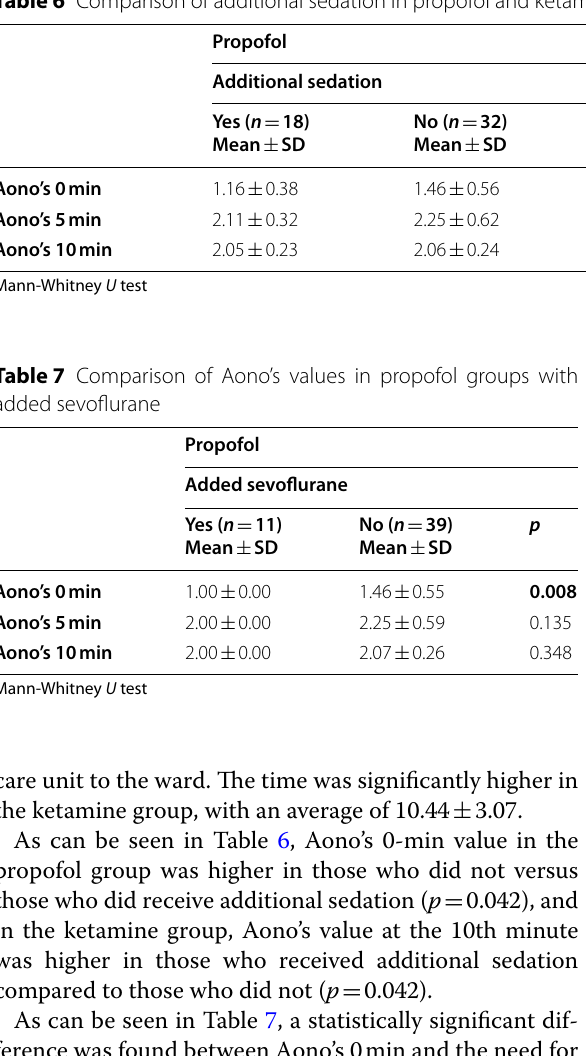
6 in propofol and ketamine groups ≥